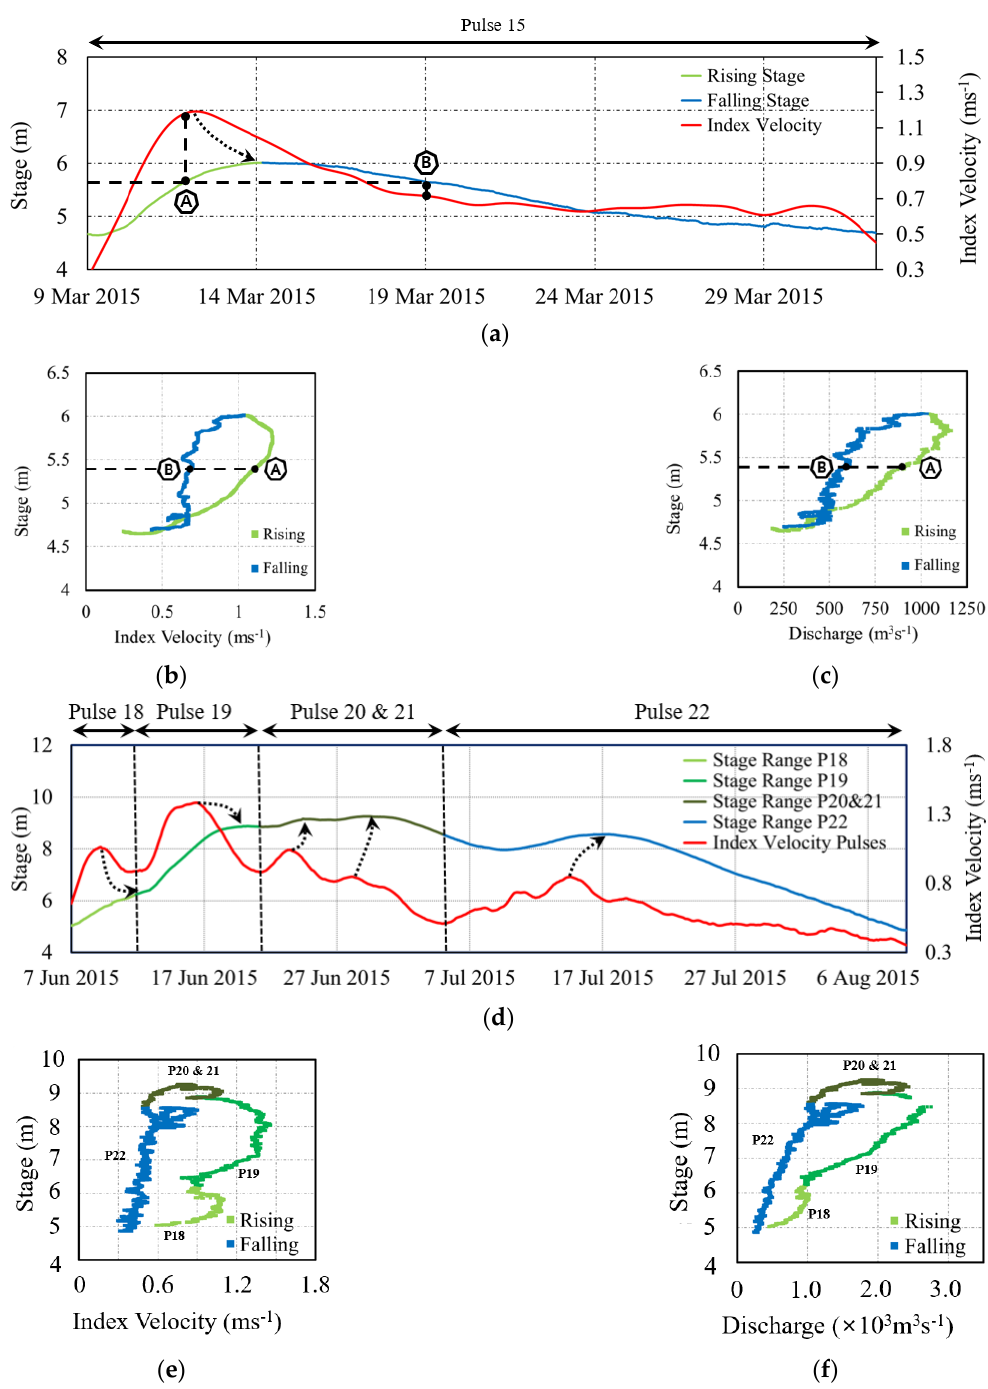
Figure 6. Illustration of hysteretic features in time−dependent and time-independent relationships between flow variables: ( a – c ) single-pulse storm event; ( d – f ) multi−pulse storm event.